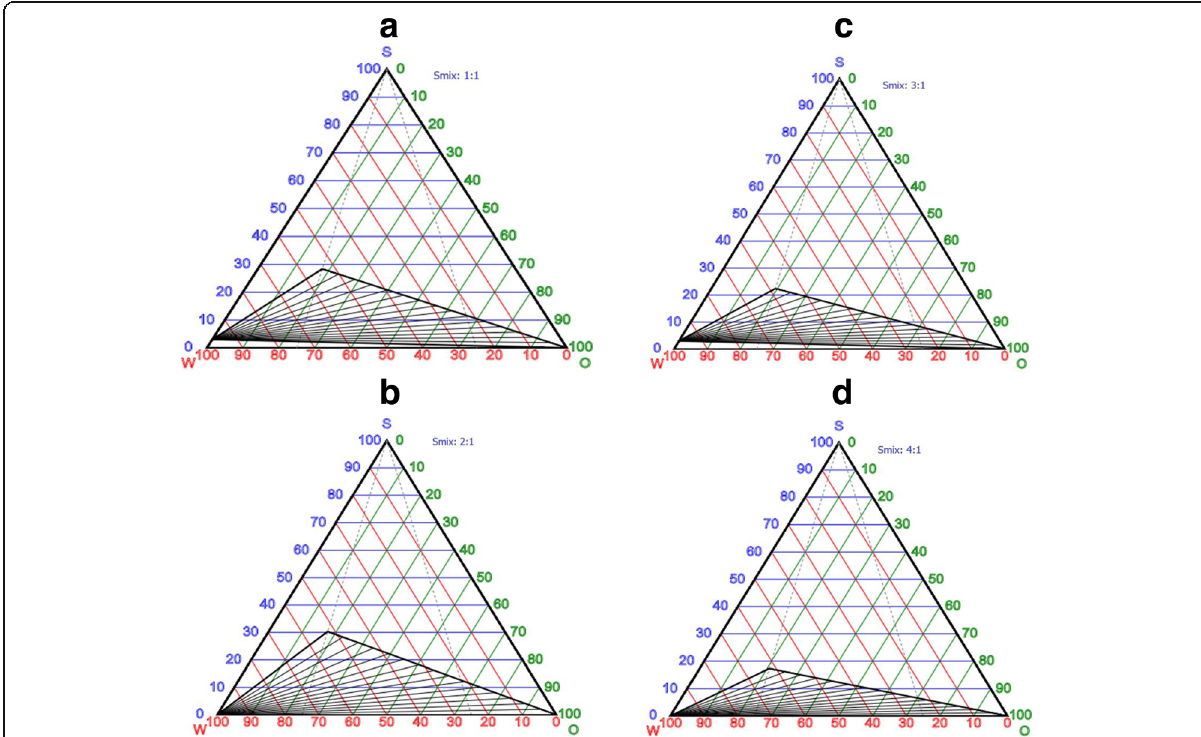
Fig. 1 a The pseudoternary phase plot of S mix (Tween 80:Transcutol P) at 1:1 ratio. b The pseudoternary phase plot of S mix (Tween 80:Transcutol P) at 2:1 ratio. c The pseudoternary phase plot of S mix (Tween 80:Transcutol P) at 3:1 ratio. d The pseudoternary phase plot of S mix (Tween 80:Transcutol P) at 4:1